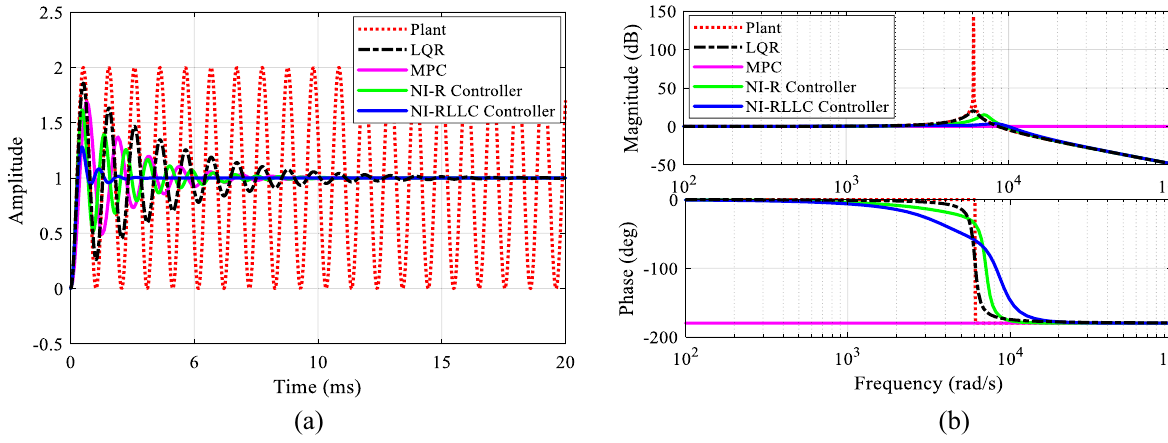
Fig. 6 Single‑phase a step response comparison of different controllers and b bode plot comparison of different